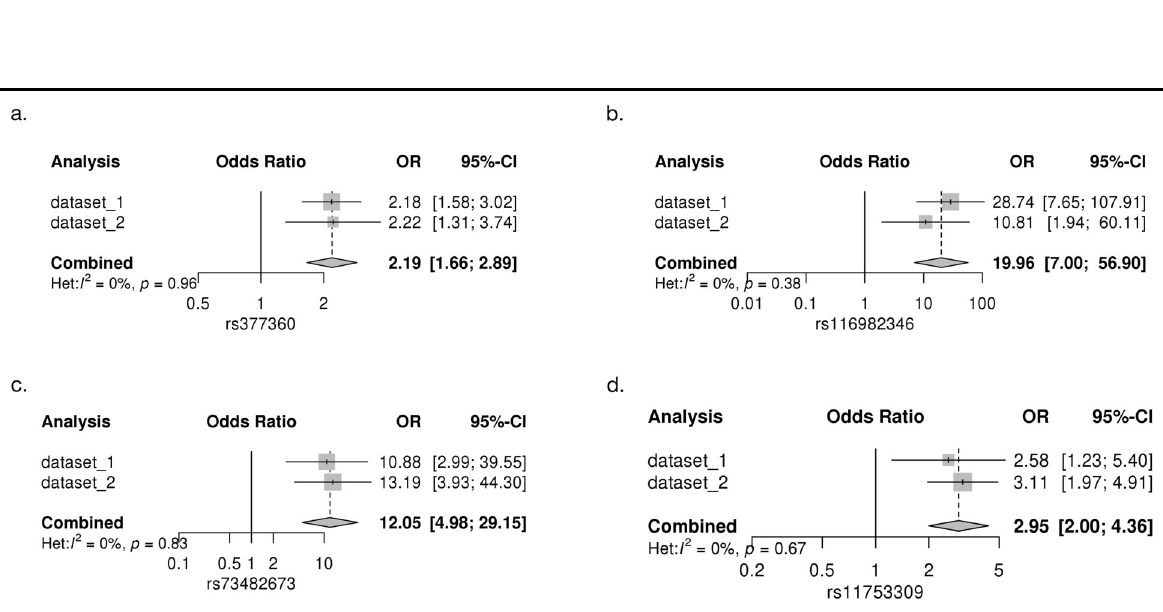
Fig. 4 Forest plots for the lead GWS variants in common variant analyses. a ) rs377360. b ) rs116982346. c ) rs73482673. d ) rs11753309. Area of the square represents the weight of each statistical sample; horizontal lines represent OR and 95% CI in two independent datasets. The diamond represents the total 95% CI estimated in meta-analysis. OR, odds ratio; CI, con fi dence